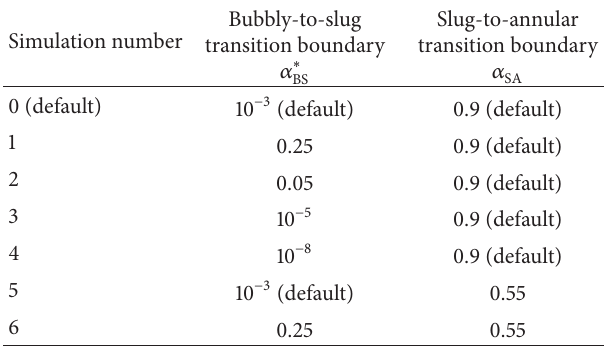
Table 6: Simulations with different flow regime transition bound- aries.